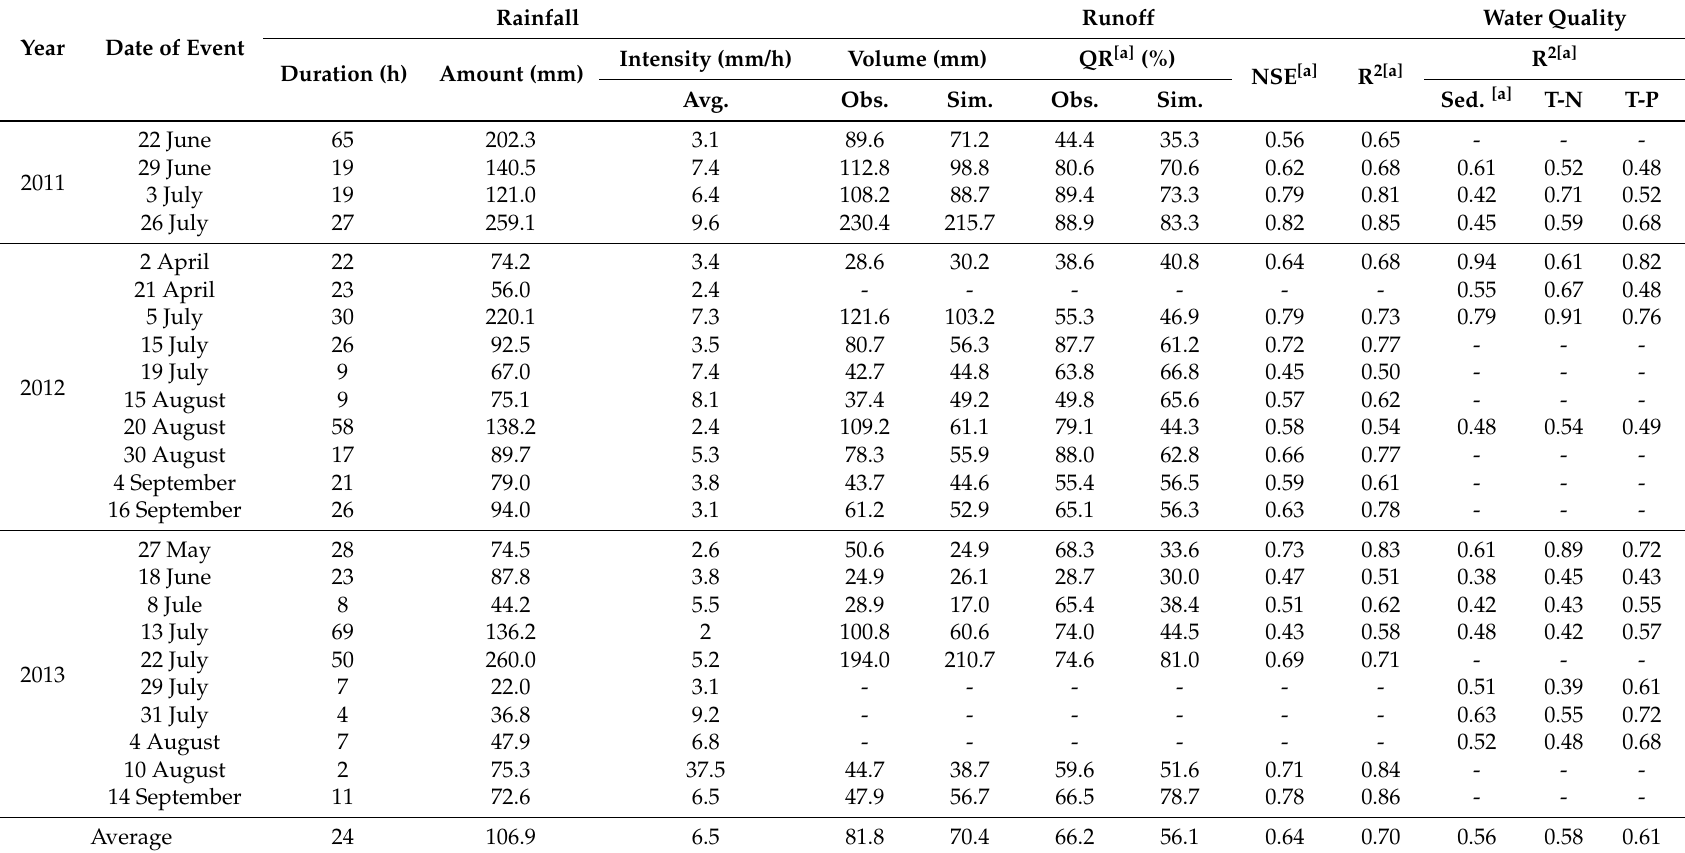
Table 2. Statistical summary of the HSPF calibration (2011–2012) and validation (2013)